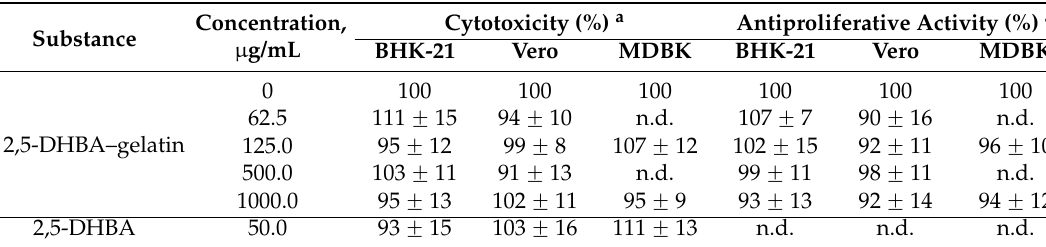
Table 1. Cytotoxic and antiproliferative activity of 2,5-dihydroxybezoic acid (DHBA)–gelatin